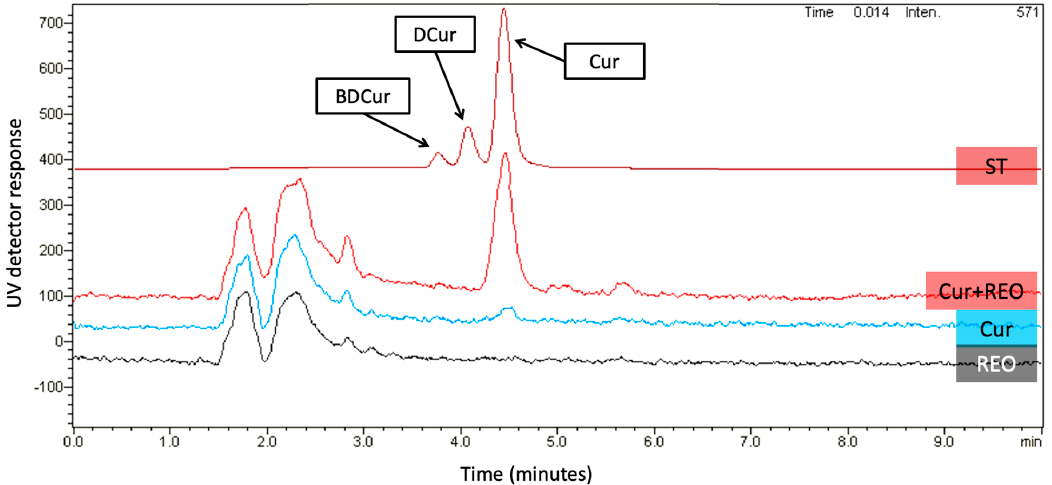
Figure 8. The HPLC analysis of curcumin (Cur) and rosemary essential oil (REO) in the plasma of animals under investigation. Blood plasma was prepared and analyzed as described in the Section